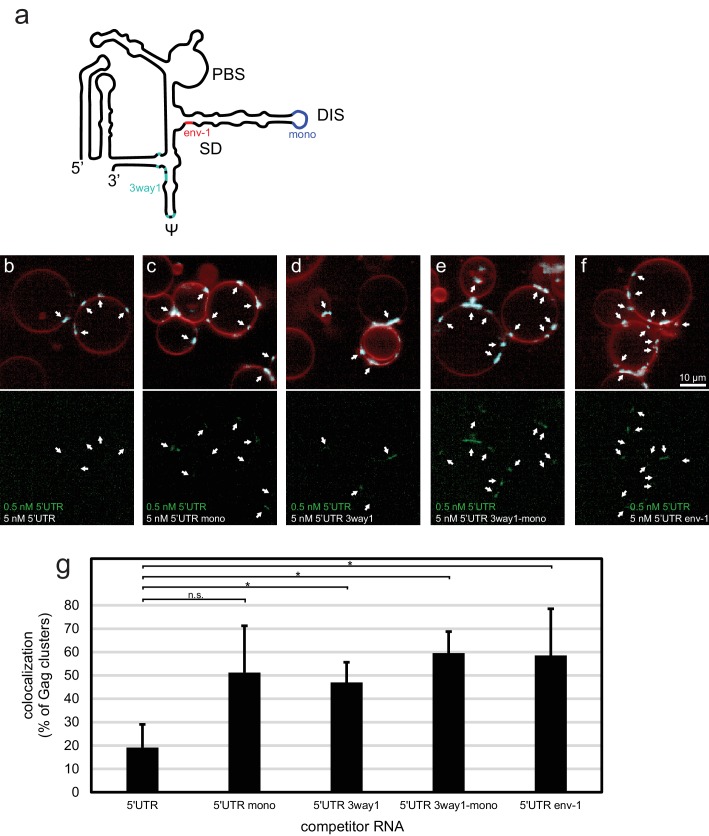
Effect of 5’UTR alterations on packaging by HIV-1 Gag.(a) Schematic of the HIV-1 5’UTR indicating introduced mutations. Blue indicates the position of the GCGCGC to GAGA mutation in the dimerization motif creating the monomerized construct '5’UTR mono'. Red indicates the position of the splice donor site G290. Replacement of nucleotides after G290 with the sequence from a spliced RNA created the construct ‘5’UTR env-1’. Cyan indicates the position of packaging-critical unpaired and weakly paired guanines mutated to adenines in the construct '5’UTR 3way1'. PBS, primer binding site. DIS, dimerization signal. SD, splice donor site. ψ, psi stem loop. The schematic shows one monomer of the dimerizing 5’UTR. (b–f) Confocal micrographs of GUVs, 10 min after adding 100 nM Gag-ATTO594, 0.5 nM 5’UTR -Alexa488, and 5 nM non-fluorescent competitor RNA as indicated. Upper panels, membrane in red and Gag in white/cyan. Lower panel, RNA. White arrows mark Gag clusters on GUVs, and their position on the corresponding RNA images. Scale bar for all images, 10 µm. (g) Quantitation of fluorescent RNA binding to Gag clusters, performed as for Figure 1g but using a lower threshold of 1.25 for counting Gag clusters as positive for fluorescent RNA. n.s./*, not significant, and significant, respectively, at p<0.05 level by Student's t-test.